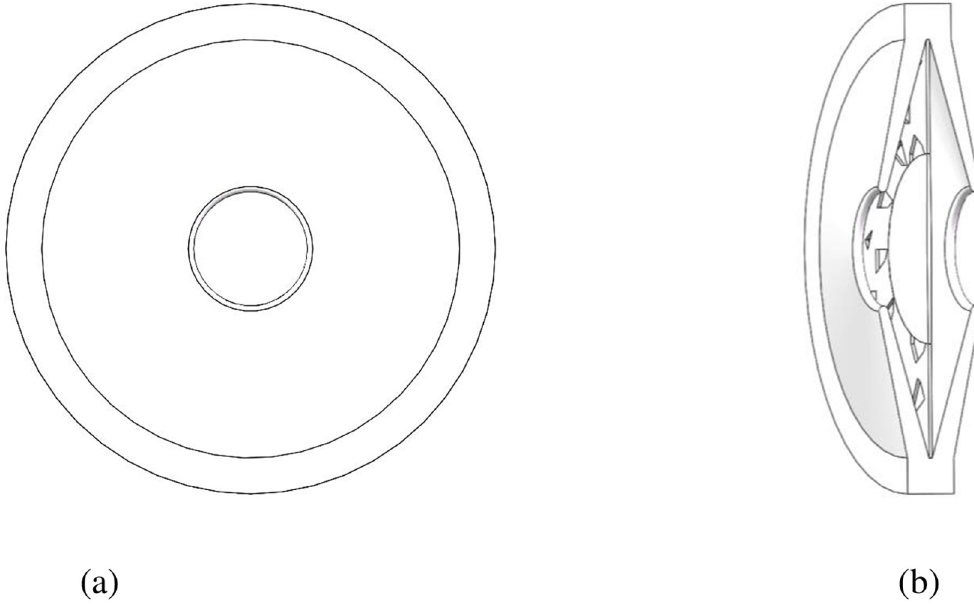
Fig 4. Schematic diagram of the TPS model. (a) Front view of pit structure. (b) Sectional view of pit structure.